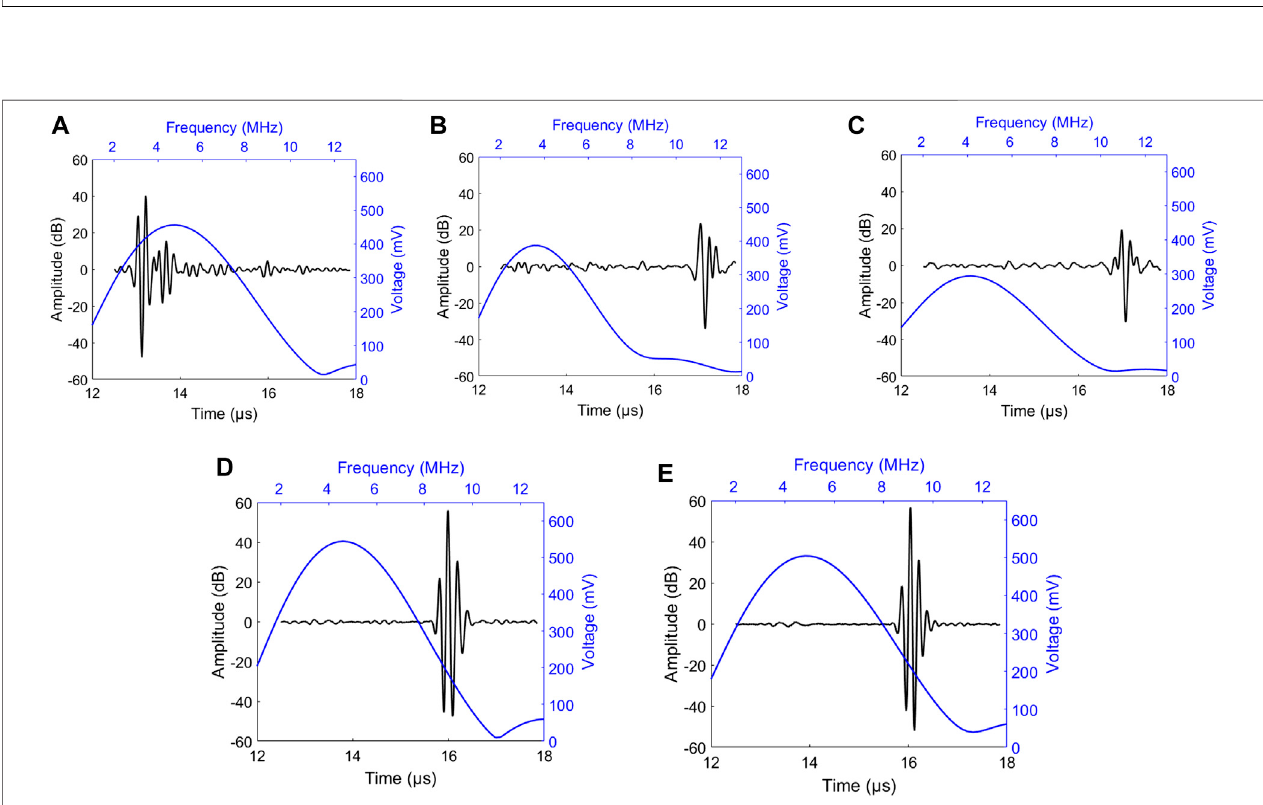
FIGURE 9 | Pulse-echo waveforms and frequency spectra of the transducer: (A) element 1; (B) element 2; (C) element 3; (D) element 4; (E) element 5.